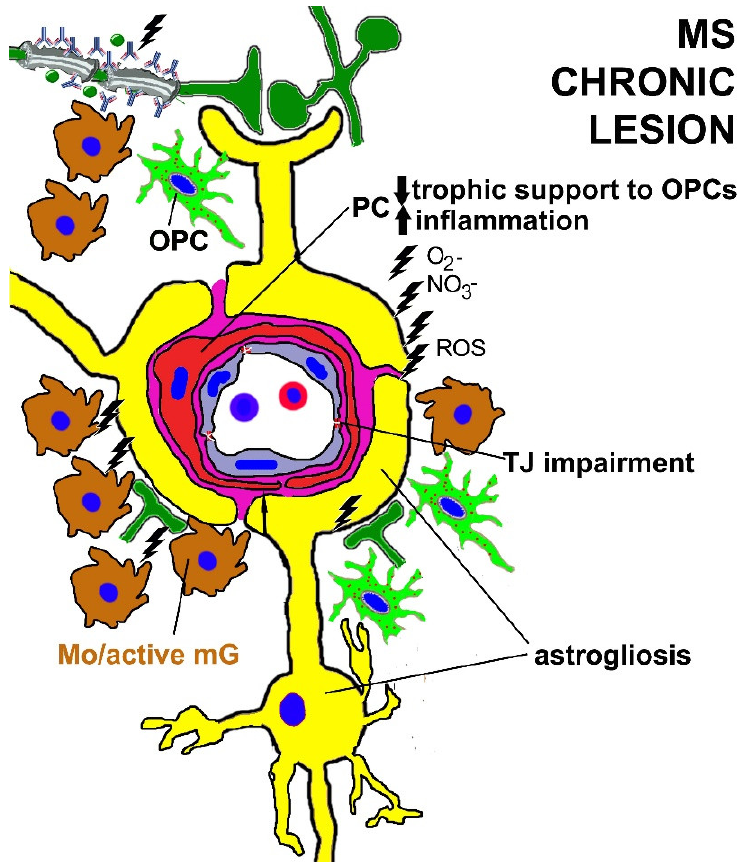
Figure 3. A schematic depiction of NVU components in a chronic end-stage MS lesion dominated by hypoperfusion and a persistent inflammatory milieu with abundant reactive oxygen species (ROS, O 2− ), peroxynitrite (NO 3− ). Vessel-associated microglial cells, monocytes, macrophages (Mp) and autoantibodies induce persistent neuroinflammation, also responsible for pericyte (PC) dys- functions. PCs release pro-inflammatory molecules and reduce the trophic support to oligodendro- cyte precursor cells (OPCs)/NG2-glia. The drawing also shows the inflammatory influence of de- myelination on reduced axonal activities and vasoconstriction. Hypoperfusion is also attributable to vessel wall hyalinization, collagen deposition and astrocyte endfeet hypertrophy. 10. PC Dysfunction in Stroke and NeuroCOVID-19 PCs are highly vulnerable to ischemic injury and appear to be responsible for an un- favourable impact on stroke-induced tissue damage and brain oedema by disrupting the microvascular blood flow and BBB integrity. As already pointed out, PCs contribute to match the metabolic demand of nervous tissue with the local microvascular blood flow (neurovascular coupling) through vasomotion [5,119,267–269], and also contribute to leu- kocyte trafficking across the BBB [246,270–274]. Ensheathing PCs, which are located at the level of penetrating arterioles and pre-capillaries, embrace ECs [269,275,276]. Transitional PCs, characterized by circumferential, merging processes with a rich in α-SMA scaffold (Figure 1), are observed along the vascular bed at various developmental stages or after pathological stimuli and show a transitional phenotype between SMCs and PCs [6,18,110,137,139,277]. PC subtypes and SMCs both respond to neural activity by the reg- ulation of vascular diameters through α-SMA myosin-based contraction [278–280] acti- vated